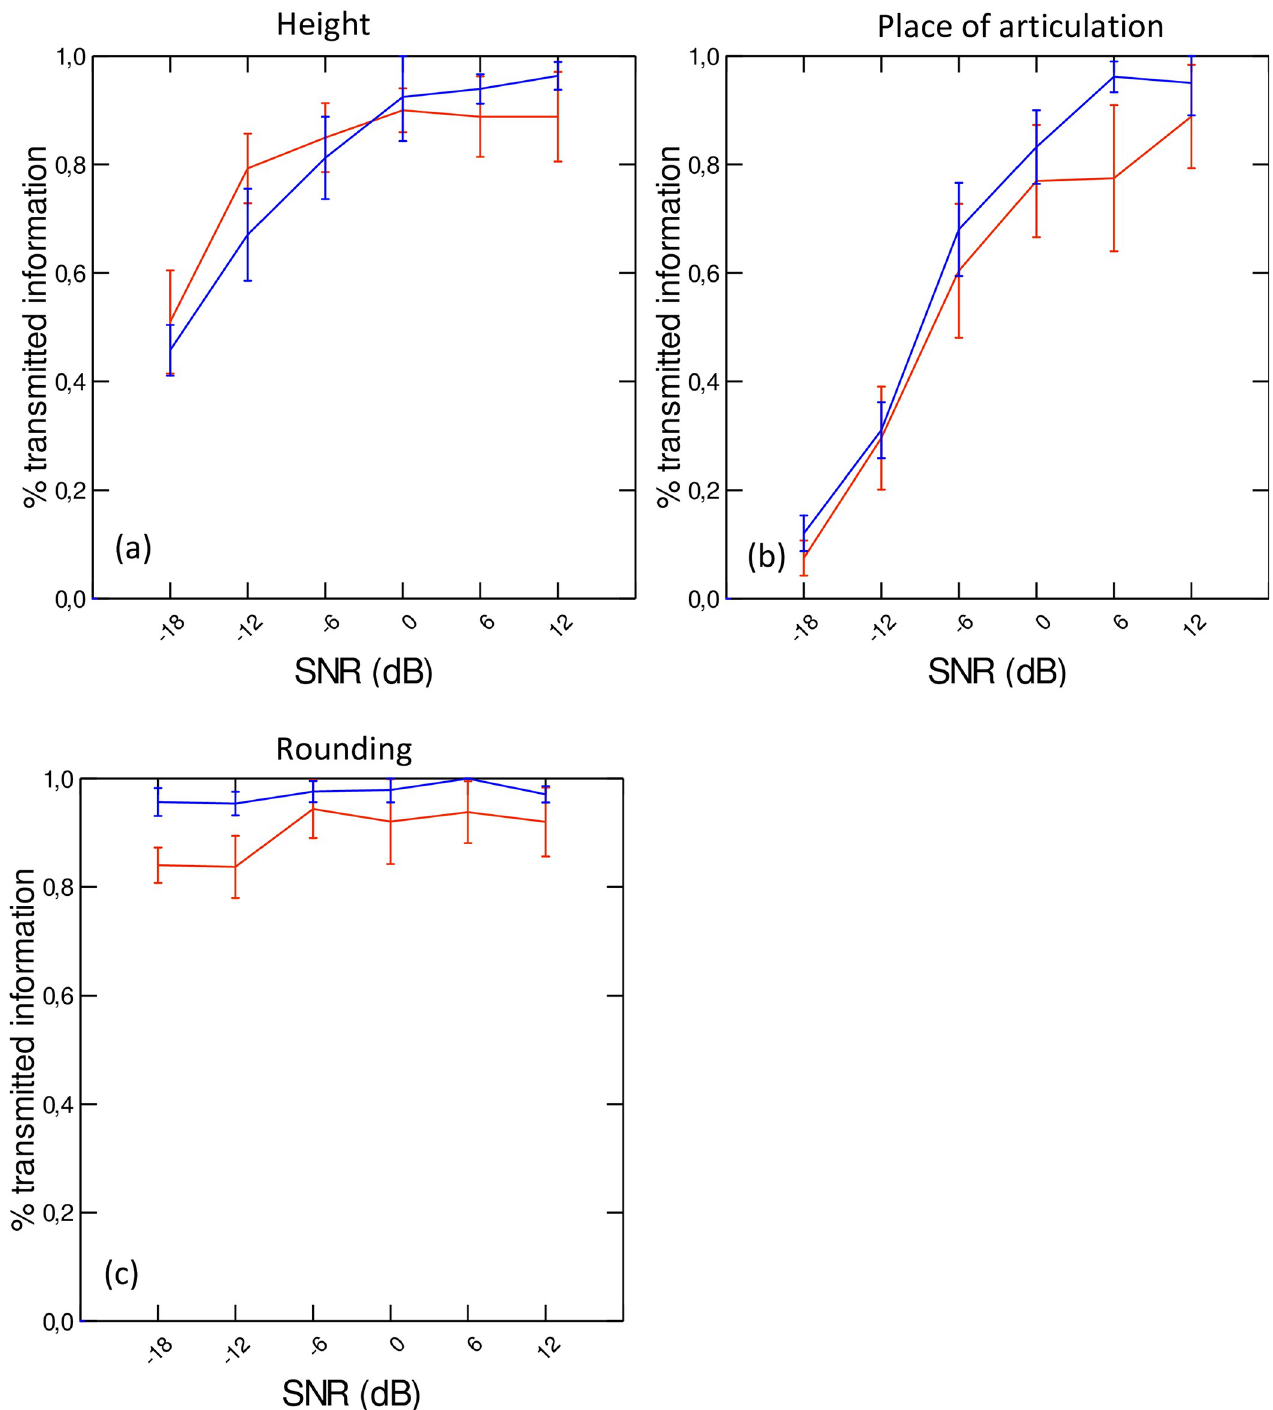
Fig 7. Percentages of transmitted information for each feature (height (a), place of articulation (b), and rounding (c)), by speaker group and SNR level. Error bars represent standard errors.